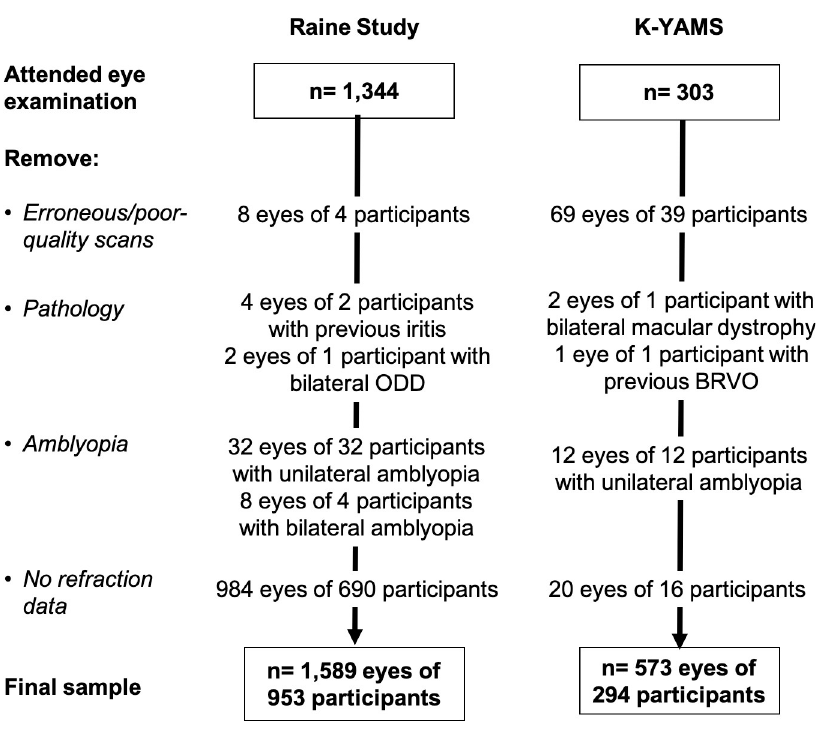
Fig 2. Sample size and reasons for exclusion from the data analysis in both the Raine Study and K-YAMS cohorts. BRVO = branch retinal vein occlusion, ODD = optic disc drusen.